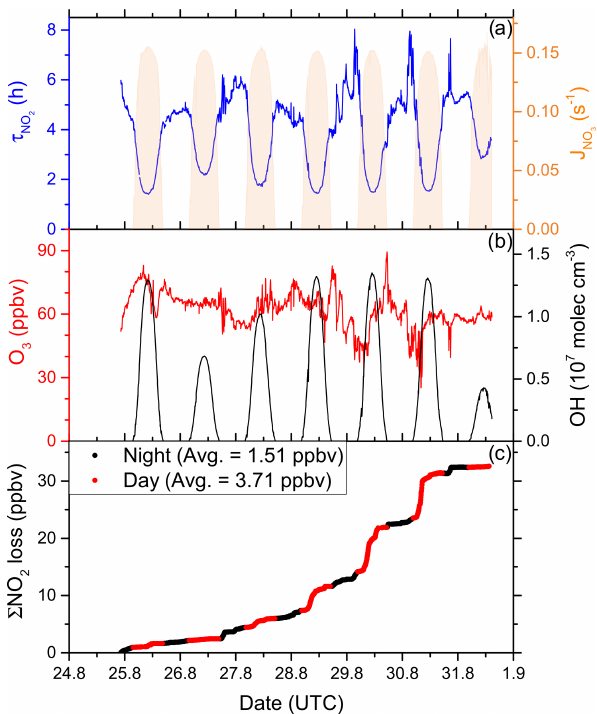
Figure 4. (a) Lifetime ( τ ) of NO 2 due to reactions with OH and O 3 in the Mediterranean Sea , together with concentrations of O 3 and OH. The OH trace is an interpolation based on OH measurements and J (see Sect. 3.1.3). Daytime hours are indicated via J NO O 1 D (b) Cumulative loss of NO 2 during the displayed time frame, based on the calculated lifetimes and measured NO 2